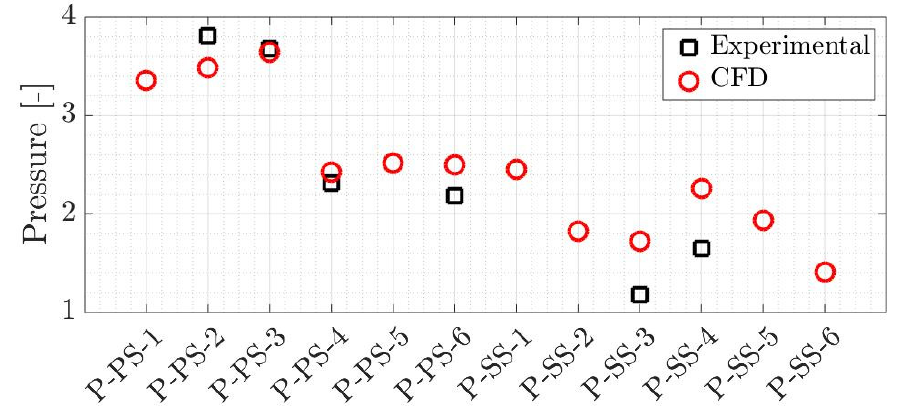
Table 4. Scaled mean absolute pressure values.